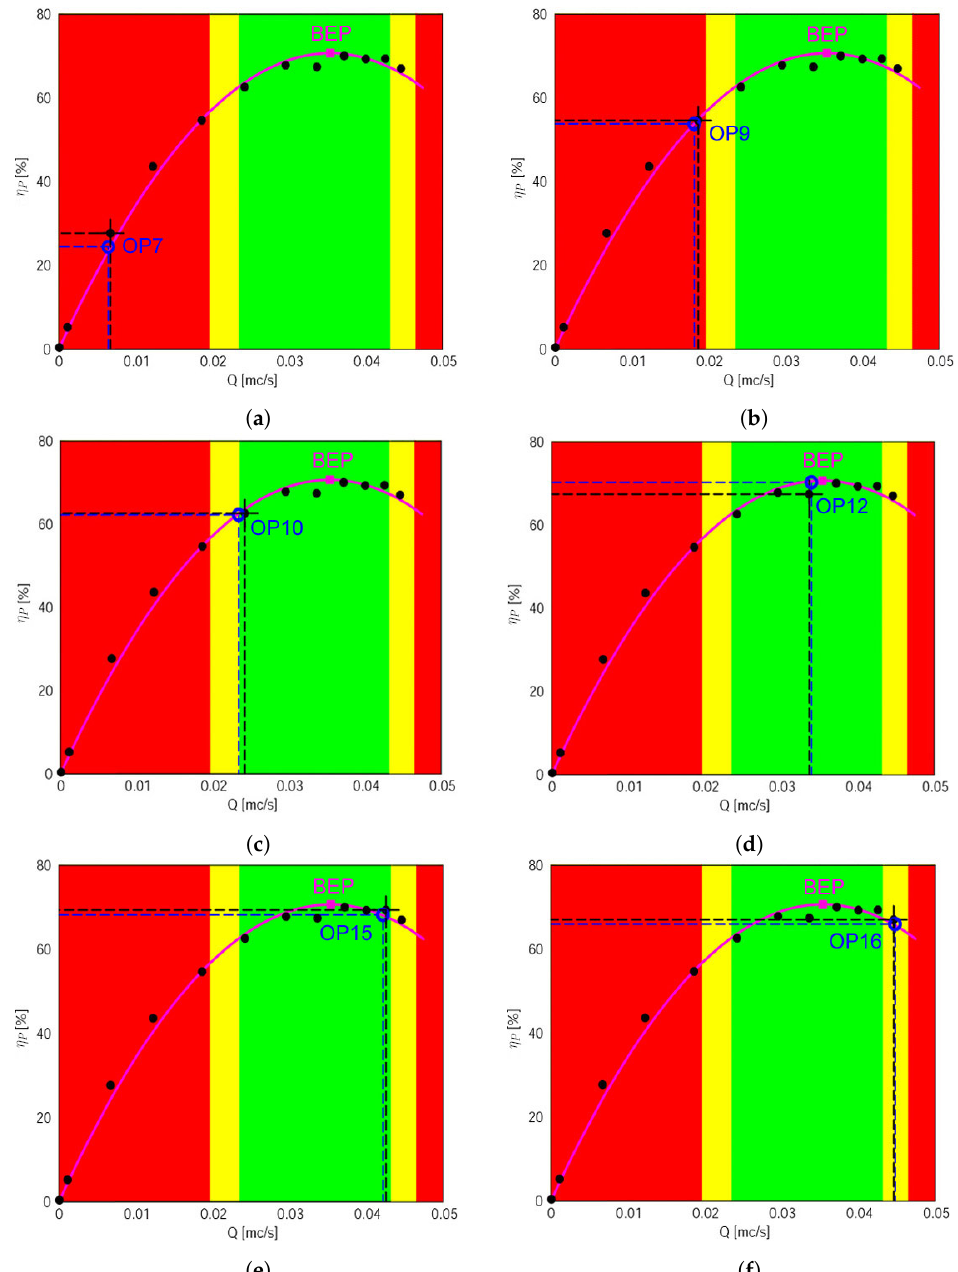
Figure 7. The validation of the algorithm for six operating points: ( a ) OP 7: Q = 6.35 × 10 − 3 m 3 /s, η P = 24.10% (AO) RED ; ( b ) OP 9: Q = 17.968 × 10 − 3 m 3 /s, η P = 53.49% (AO) RED ; ( c ) OP 10: Q = 23.21 × 10 − 3 m 3 /s, η P = 62.02% (NO) GREEN ( d ) OP 12: Q = 37.33 × 10 − 3 m 3 /s, η P = 70.21% (NO) GREEN ( e ) OP 15: Q = 41.86 × 10 − 3 m 3 /s, η P = 68.43% (NO) GREEN ( f ) OP 16: Q = 44.463 × 10 − 3 m 3 /s, η P = 66.35%; (LO) YELLOW